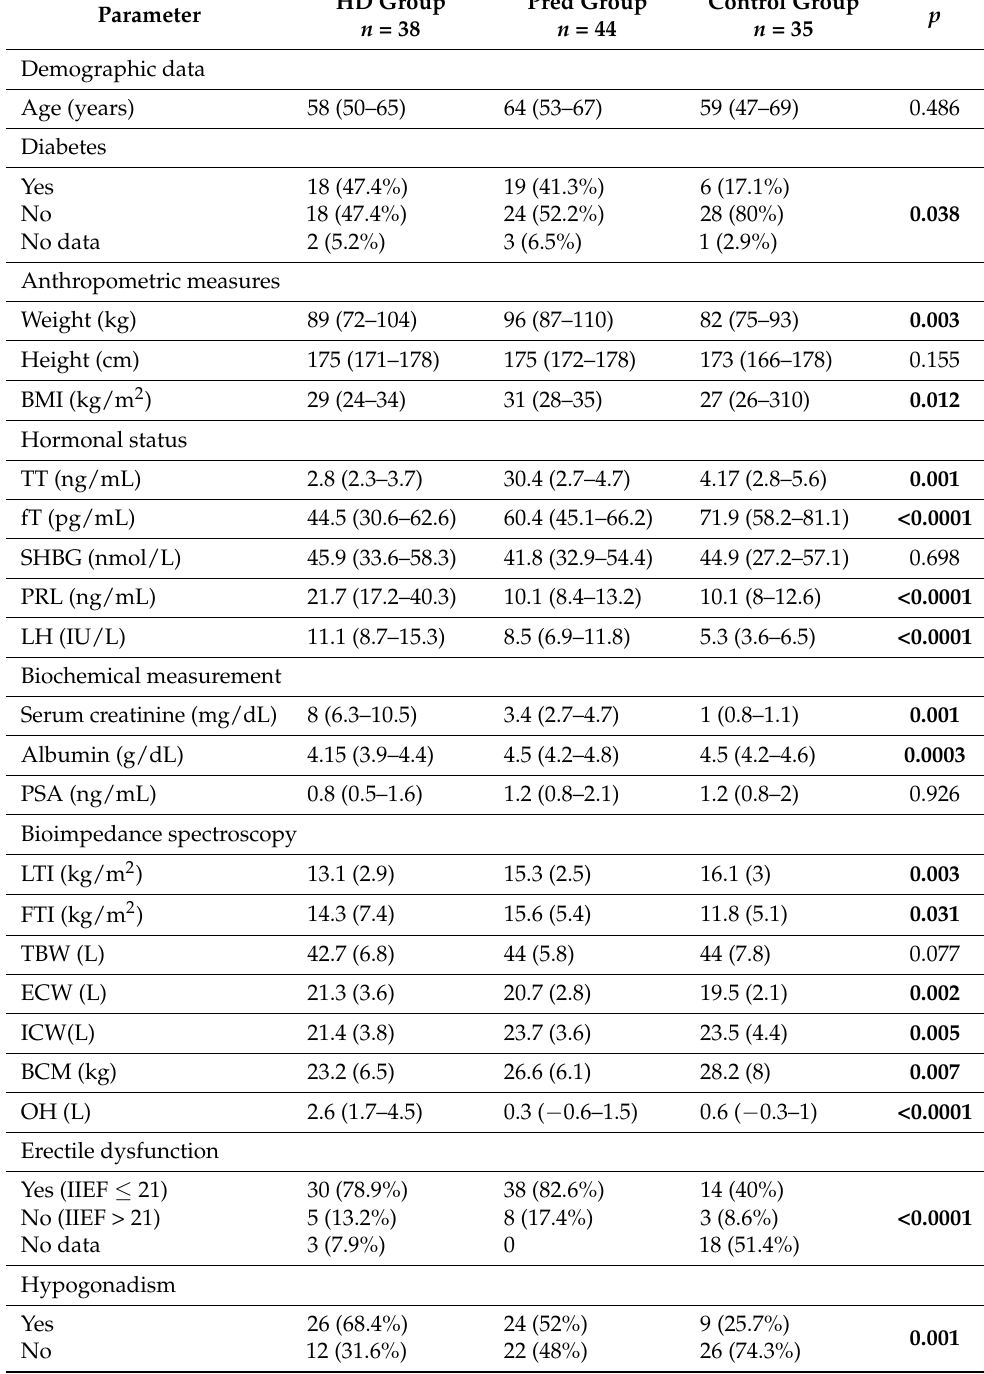
Table 1. The initial group